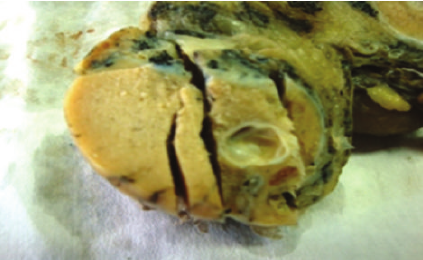
Figure1:Macroscopicappearanceofthesurgicalspecimen.Asolid- cystic mass with areas of calcification measuring 2.0 cm in testicular parenchyma.